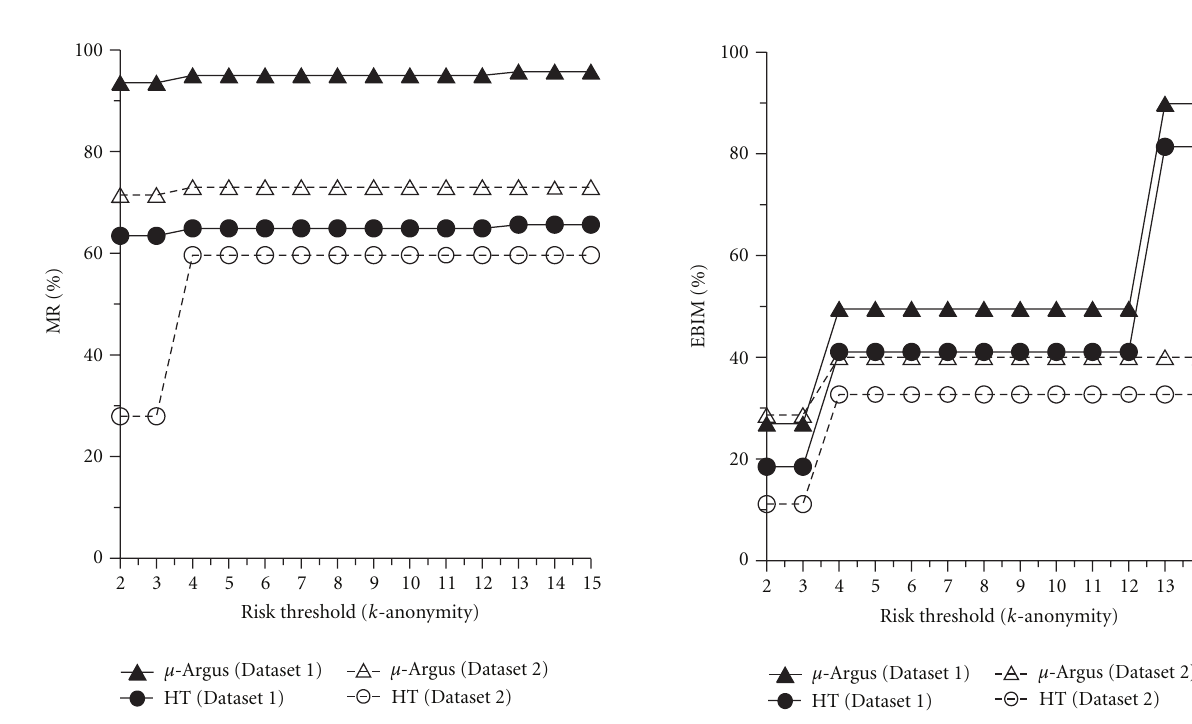
Figure 4: Data distortion analysis on Modification rate. Figure 5: Data distortion on Extended Bias in